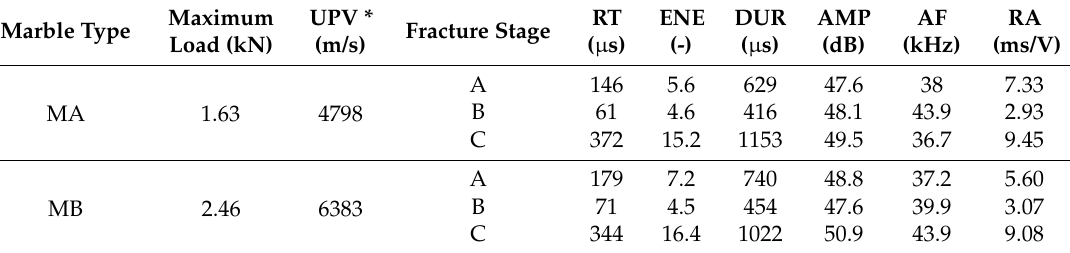
Table 2. Results of the bending tests for two types of repaired marble